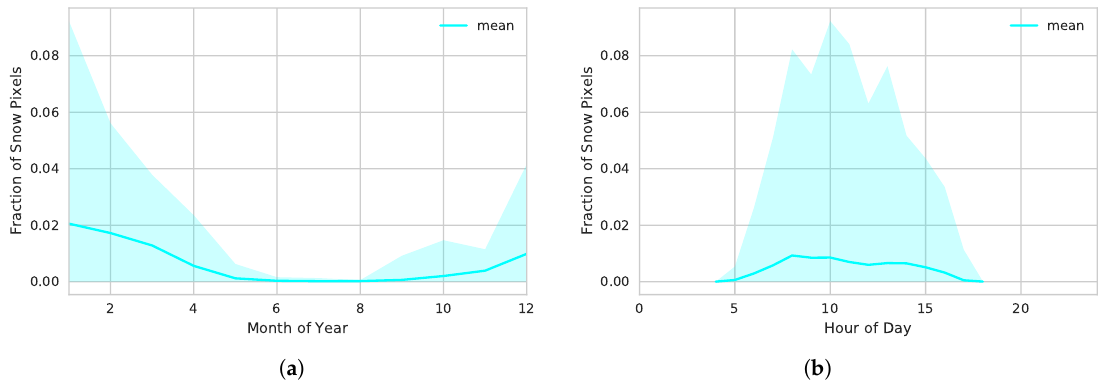
Figure 5. The two plots show the distribution of the fraction of snow pixels per CMa scene as a function of months ( a ) and hour of day ( b